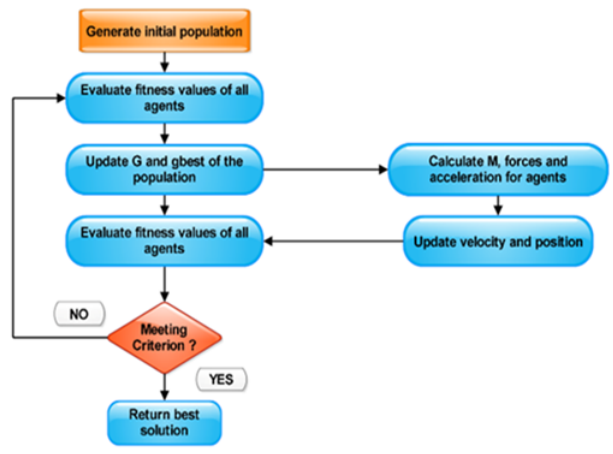
Figure 5. Flowchart of